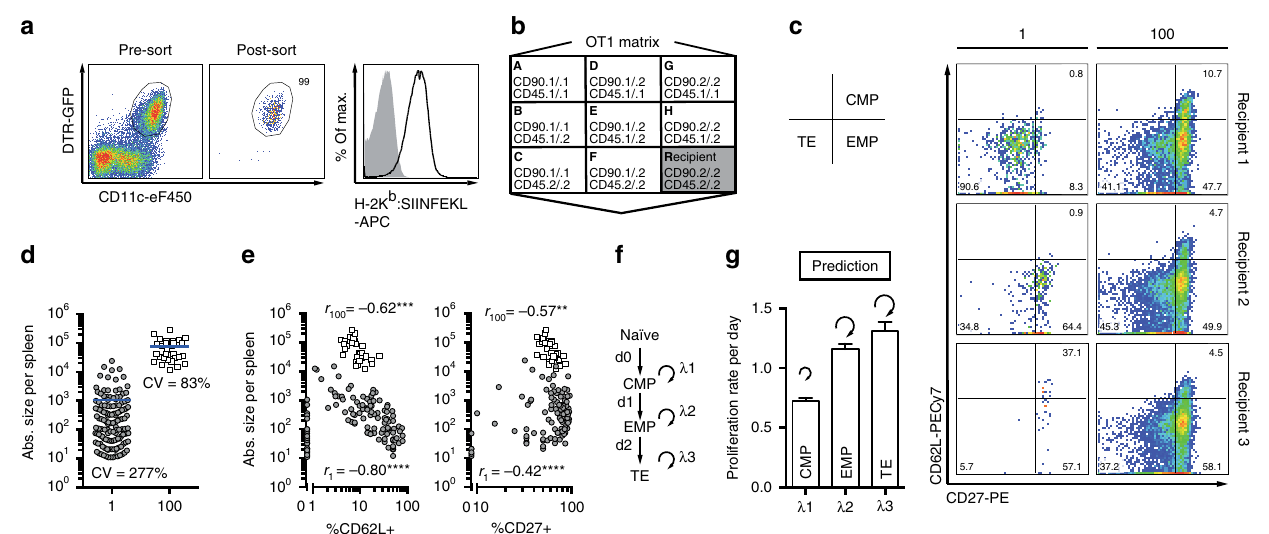
Fig. 1 Computational modelling based on single T cell fate mapping suggests slower proliferation rates of CMPs. a Sorting strategy of DCs (pre-gated: CD19 − CD3 − ) and detection of H-2K b (MHC-I)-SIINFEKL after peptide-pulsing (grey: isotype control). b Scheme depicting genotypes of OT1 congenic matrix donors (A – H) and C57BL/6 recipients (R). c – e Progenies were recovered from spleen at day 8 after DC + L.m . immunization per transferred one cell (grey circles, n = 138) and 100 cells (white squares, n = 30). c Representative pseudo-colour plots showing expression of CD27 and CD62L for large to small single-cell-derived progenies, together with the respective 100-cell-derived progenies in the same recipients. d Scatter plot depicts the absolute number of daughter cells. e Scatter plots depict the correlation of progeny size and percentage of CD62L or CD27 expressing cells. f Model scheme used for fi tting to the experimental data. g Bar graph depicts model prediction of subset-speci fi c proliferation rates ( λ 1 – λ 3 ) per day, with bootstrap-error. Lines depict the mean, ‘ CV' indicates the coef fi cient of variation ( d ). **** P < 0.0001, *** P < 0.001, ** P < 0.01 (Spearman non-parametric testing ( e )). Data are from nine independent experiments. Source data are provided as a Source Data fi